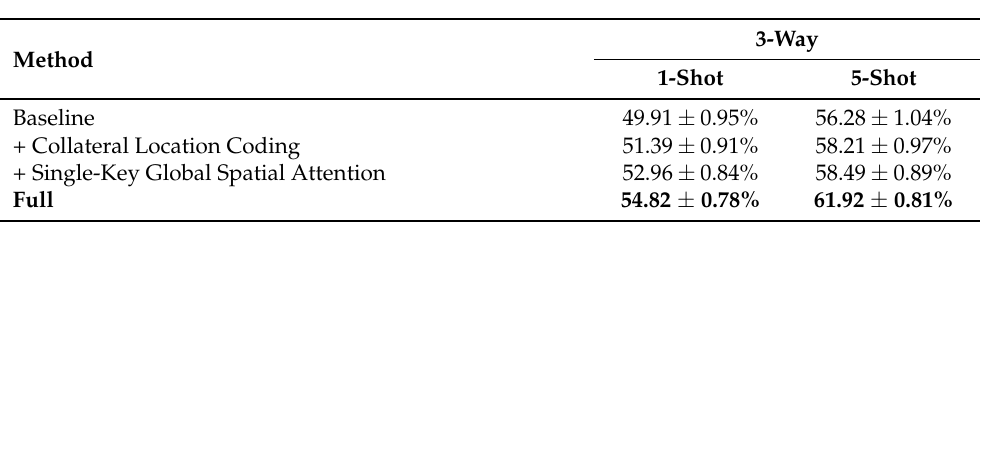
Table 6. Ablation on the PathMNIST